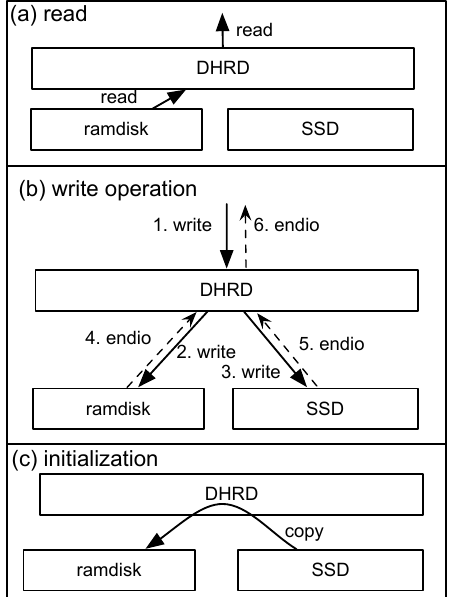
Figure 3. The three primitive operations of the durable hybrid RAM disk; read, write and